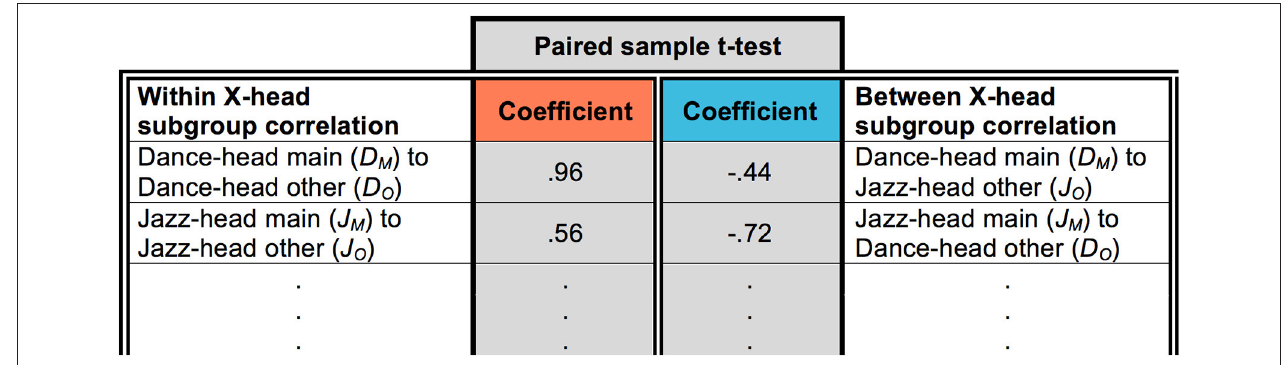
FIGURE 4 | Example of paired sample t -test with respect to Energy in which within-group coefficients were paired with between-group coefficients. Only the first two from 38 pairs are shown.